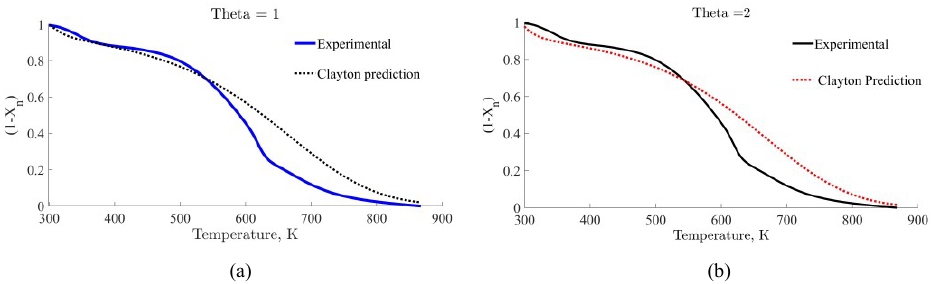
Fig. 7. Comparison between experimental data and the n th order bi-variant scheme for DAEM: (a) θ = 1; (b) θ =